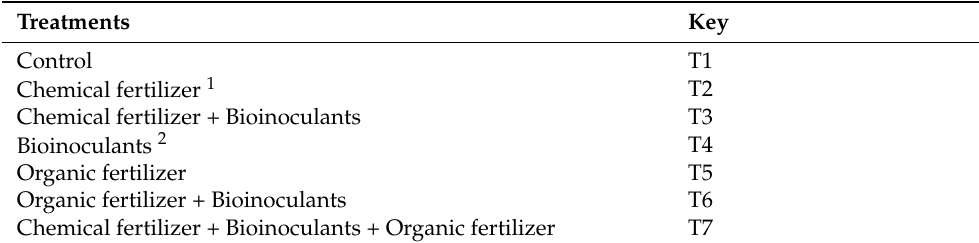
Table 1. Different fertilization schemes used for the treatments evaluated in the growth and yield